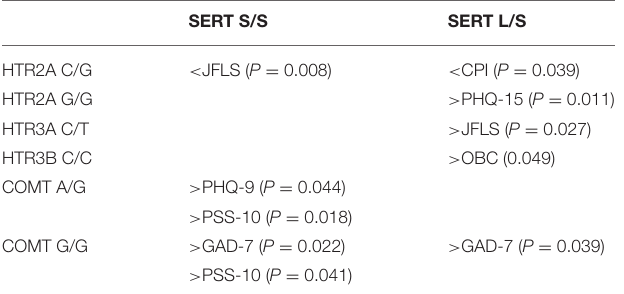
TABLE 5 | Significant interactions between SERT rare homozygous (S/S) and heterozygous (L/S) genotypes and other genotypes on pain, psychological distress, and jaw function in 117 patients with TMD